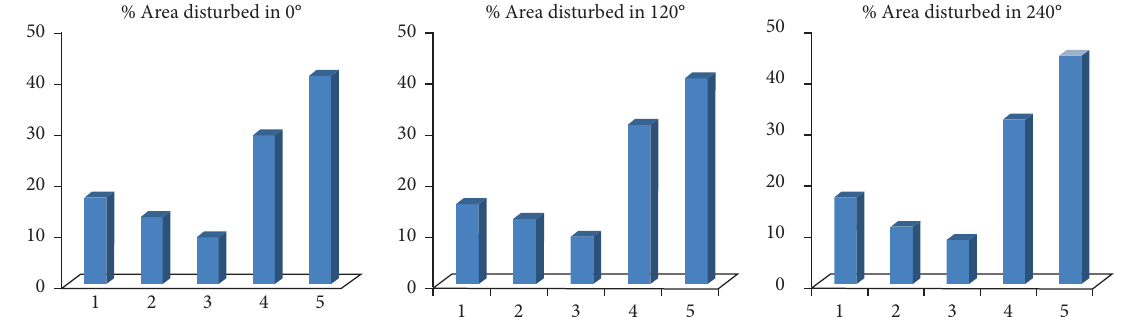
Figure 8: Te amount of area of forest disturbed by human disturbance from the inner quadrats (1) to the edge of the church forest